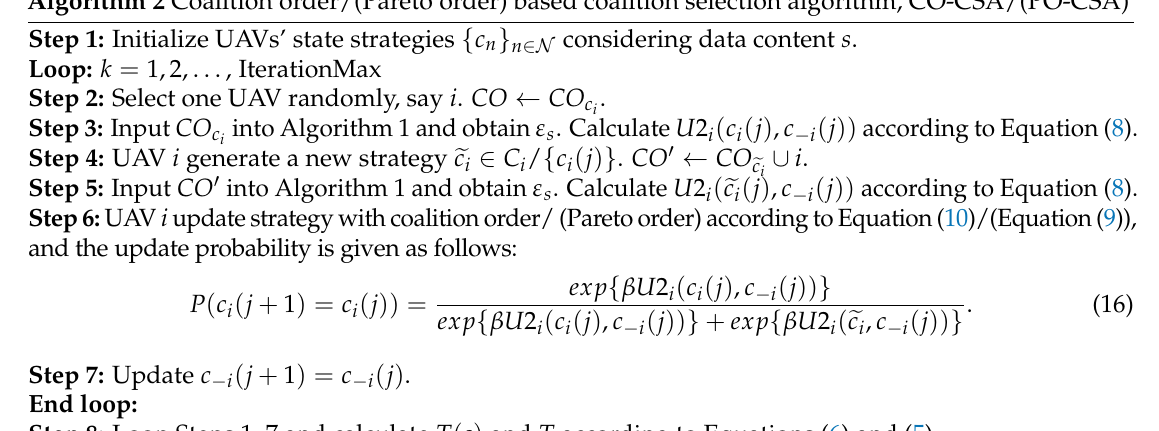
Algorithm 2 Coalition order/(Pareto order) based coalition selection algorithm,